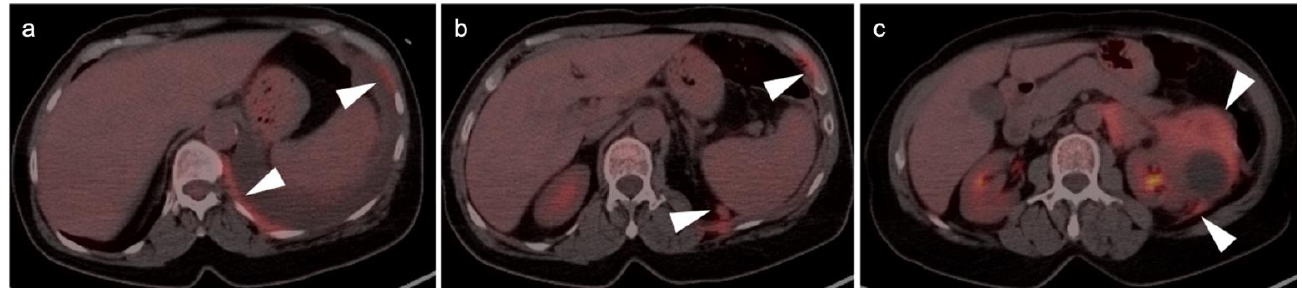
Figure 48. Sarcomatoid cell carcinoma on FDG PET-CT. ( c ) A large, hypermetabolic invasive mass arising from the left kidney extends into the pararenal space (white arrowhead); ( a , b ) The hyper- metabolic renal mass extends into the left pleural space, with an accompanying pleural effusion (white arrowheads). This was a sarcomatoid renal cell carcinoma, but the main differential would also include lymphoma.